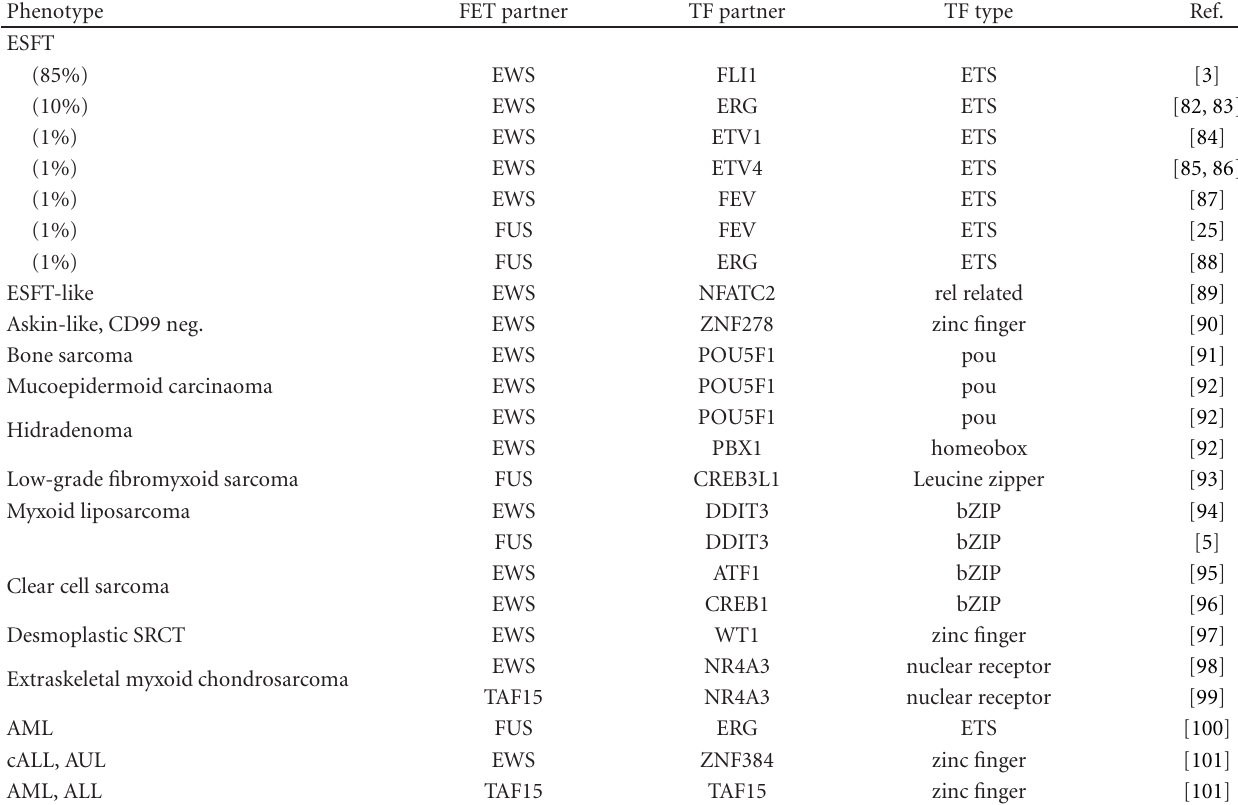
Table 2: FET gene fusions in cancer. TF: transcription